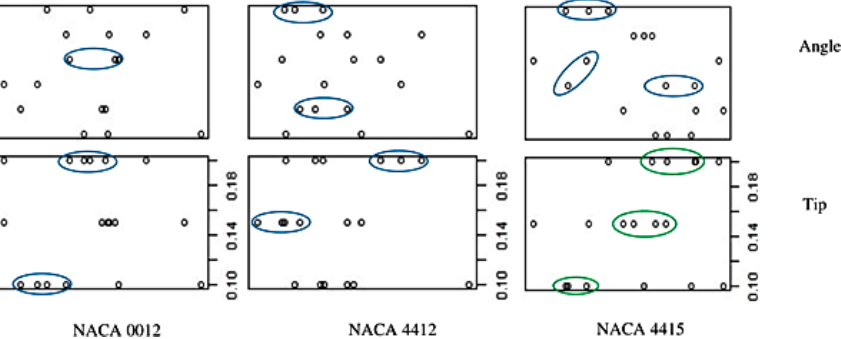
Figure 16. Three airfoils NACA 0012, NACA 4412, and NACA 4415 and the scatter plot for drag are considered for blade tip size and blade twist angle.